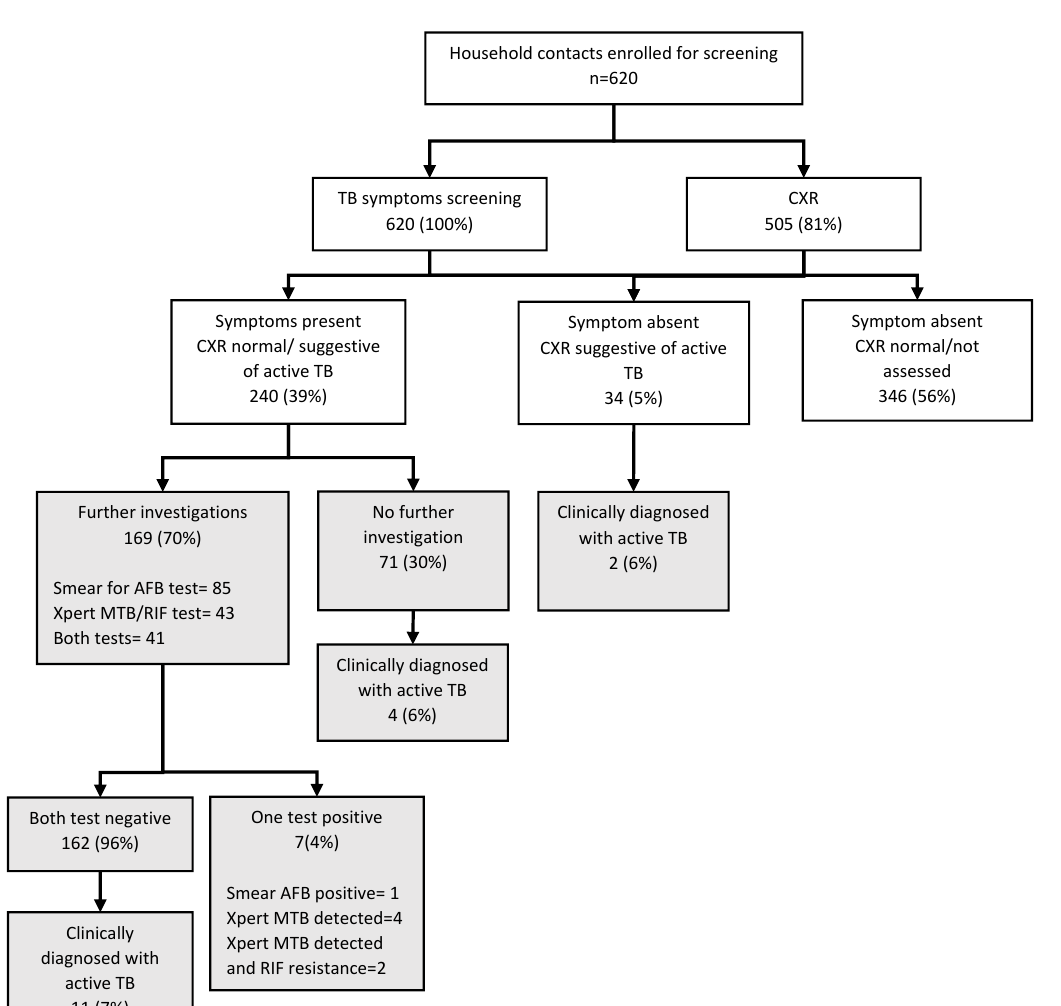
Figure 2. Number of household contacts of MDR-TB patients who underwent TB screening and